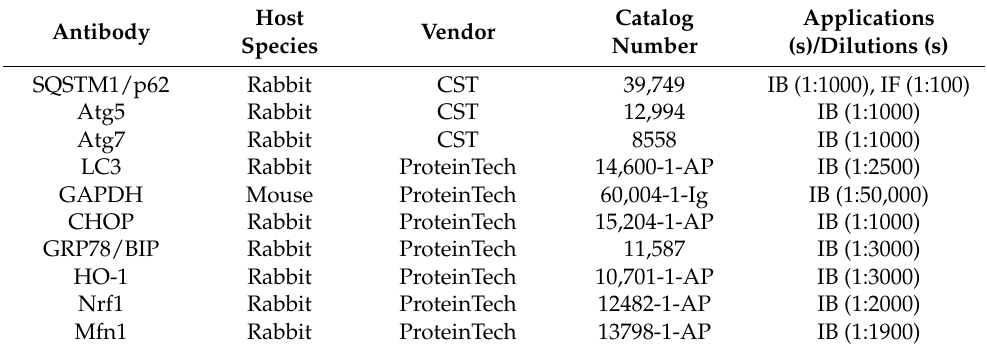
Table 1. Antibodies used for different experiments in this